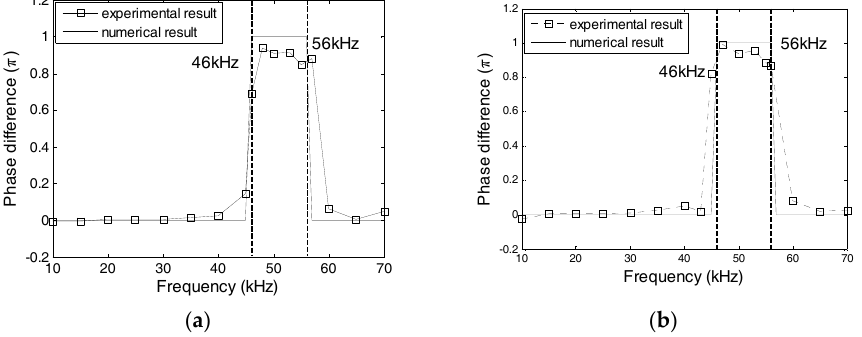
Figure 22. Phase difference between the PZT sensors in Specimens 5 and 6. ( a ) Specimen 5; ( b ) Specimen 6.